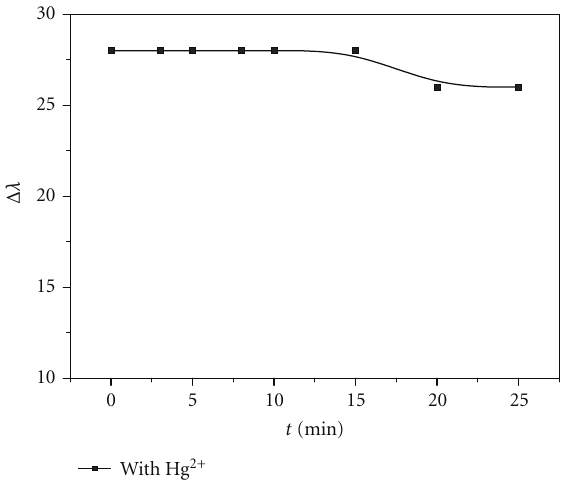
Figure 6: Stability of the reactive system. Concentration: AgNPs: 6.5 × 10 − 5 mol/L; Hg (II) ion: 6.0 × 10 − 6 mol/L; t (min): 0, 3, 5, 8, 10, 15, 20, 25, respectively; HAc-NaAc bu ff er (pH 5.6).